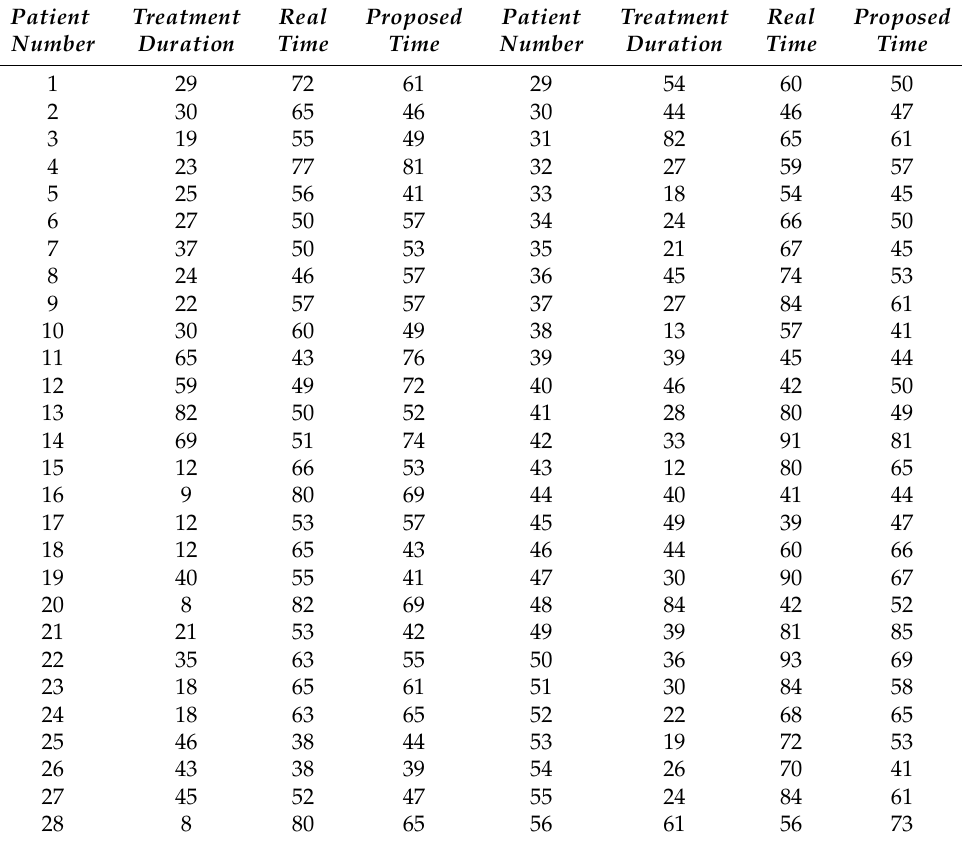
Figure 8. Comparison of the number of oncology treatments in progress actually being performed and those proposed by the deterministic optimization model (120 min of margin) at each point in time on Monday, 11 January 2021. Axis X : time of the day between 8:00 am and 10:00 pm. Axis Y : number of treatments in progress. Table 4. Treatment duration, actual start time and start time proposed by the deterministic model with 120 min of margin, expressed in number of 5-min periods, for the 56 patients on Monday 11 January